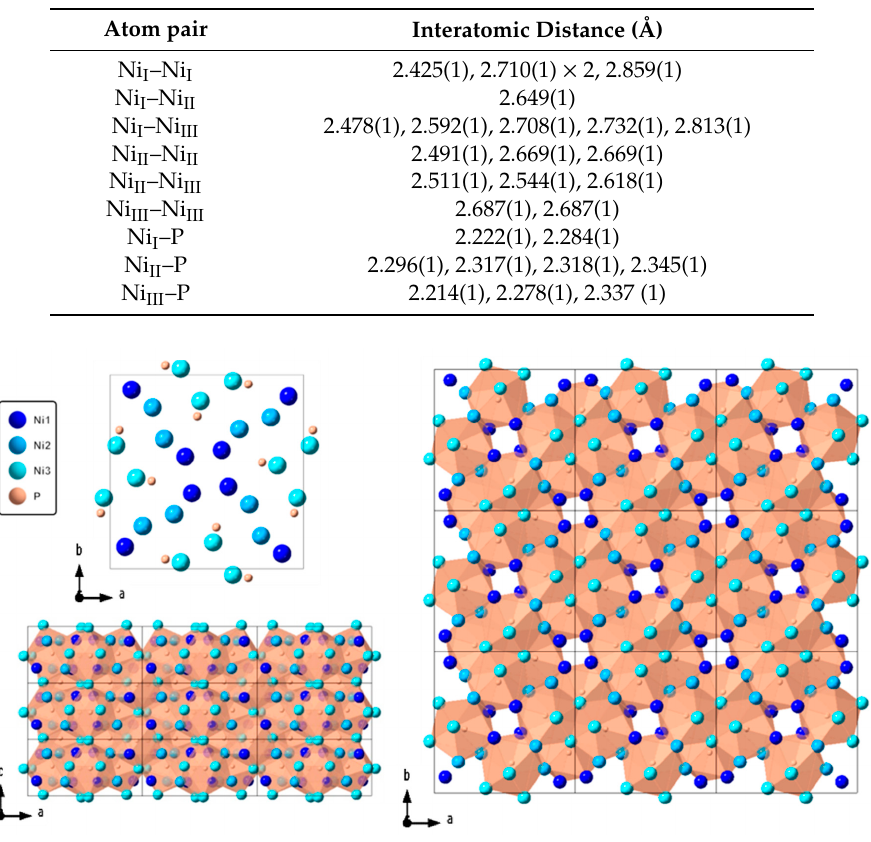
Figure 1. The crystal structure of Ni 3 P at ambient pressure and temperature.